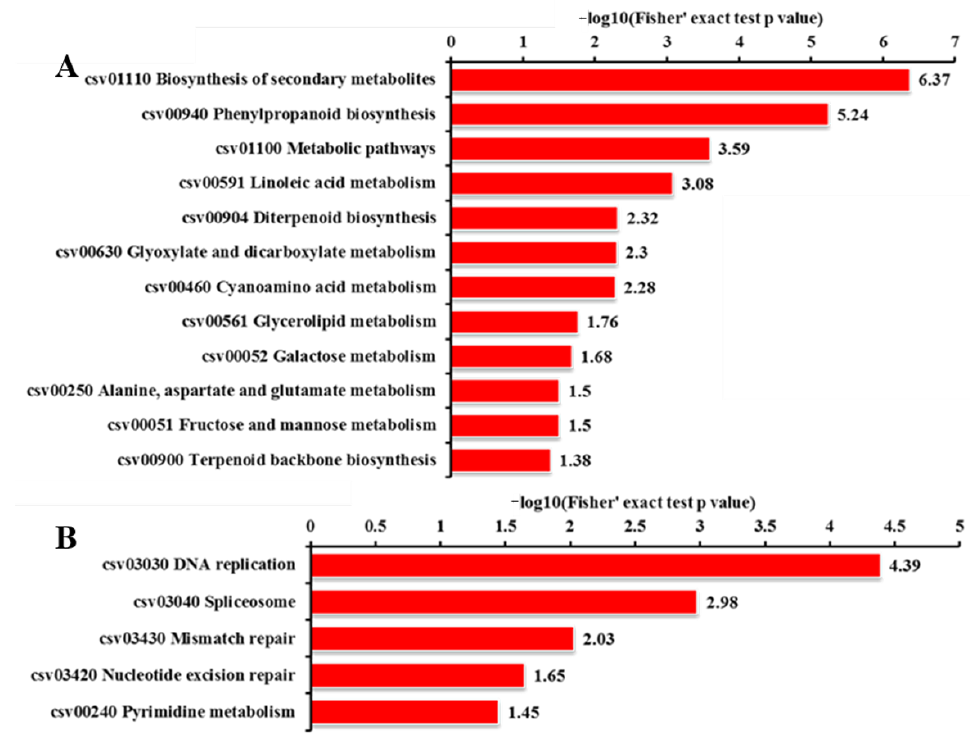
Figure 18. KEGG pathway analysis of DEPs. ( A ) KEGG pathway analysis of significantly up-regulated proteins. ( B ) KEGG pathway analysis of significantly down-regulated proteins.